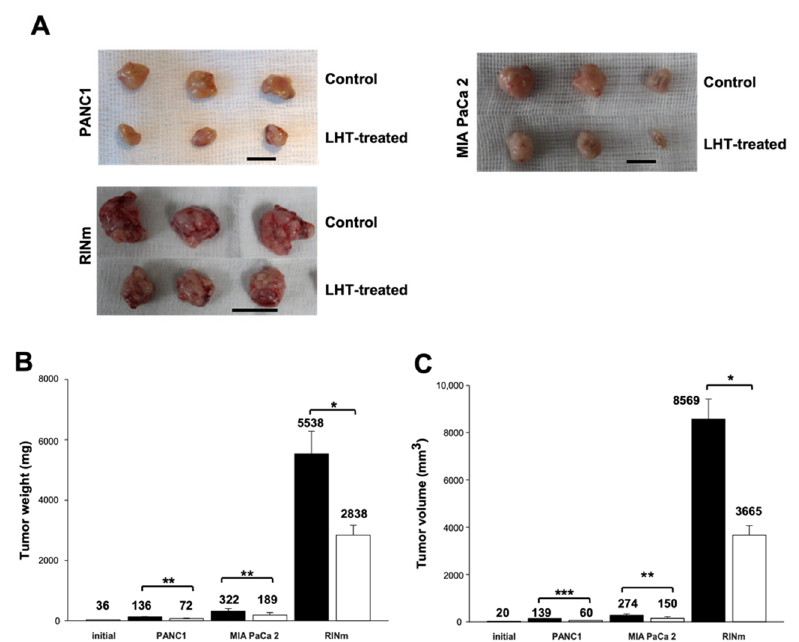
Figure 7. Inhibition of tumor growth and volume in an orthotopic pancreatic tumor during intravenous administration of LHT. ( A ) Optical images of solid tumors that were sacrificed and resected from the pancreas organ in the orthotopic pancreatic mouse after intravenous administration of LHT (5 mg/kg/once every 2 days) or PBS (control) for 30 days. Scale bars indicate 20 mm. ( B ) Tissue weight (mg) of tumor resected from control (black bar) or LHT-treated mice (white bar). Data were expressed with mean ± s.e.m. (n = 5). * p < 0.05, ** p < 0.01 versus each control groups. ( C ) Tissue volume (mm 3 ) of tumor resected from control (black bar) or LHT-treated mice (white bar). Data were expressed with mean ± s.e.m. (n = 5). * p < 0.05, ** p < 0.01, *** p < 0.001 versus each control group.